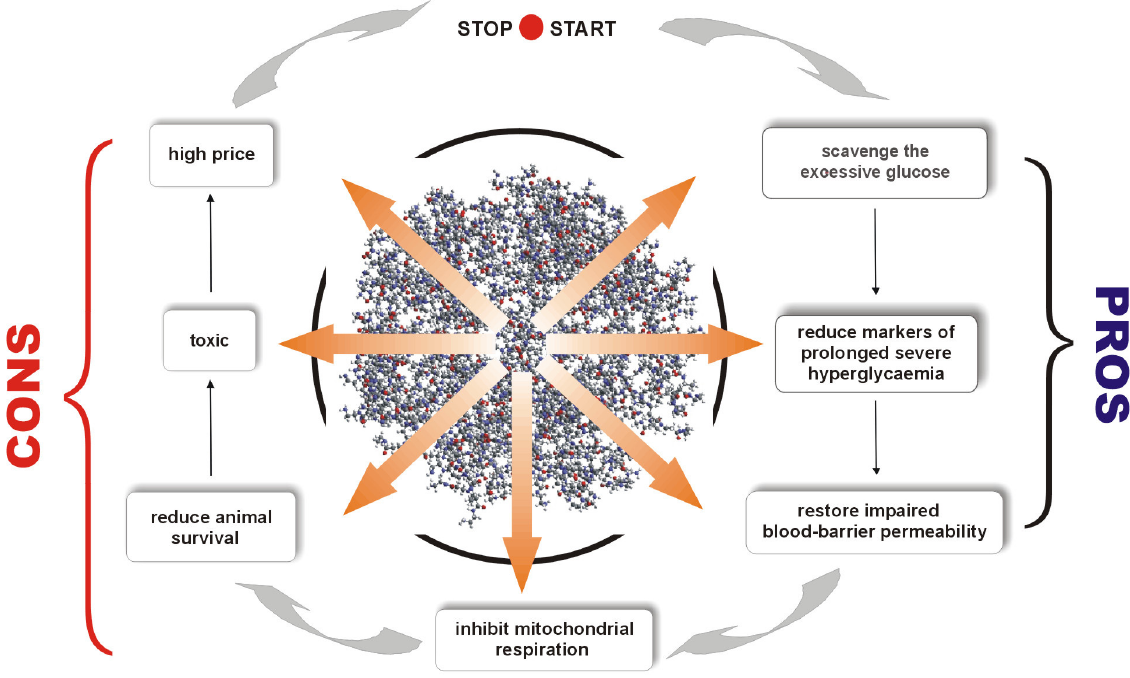
Figure 18. Advantages and disadvantages of using PAMAM dendrimers in the treatment of severe diabetic